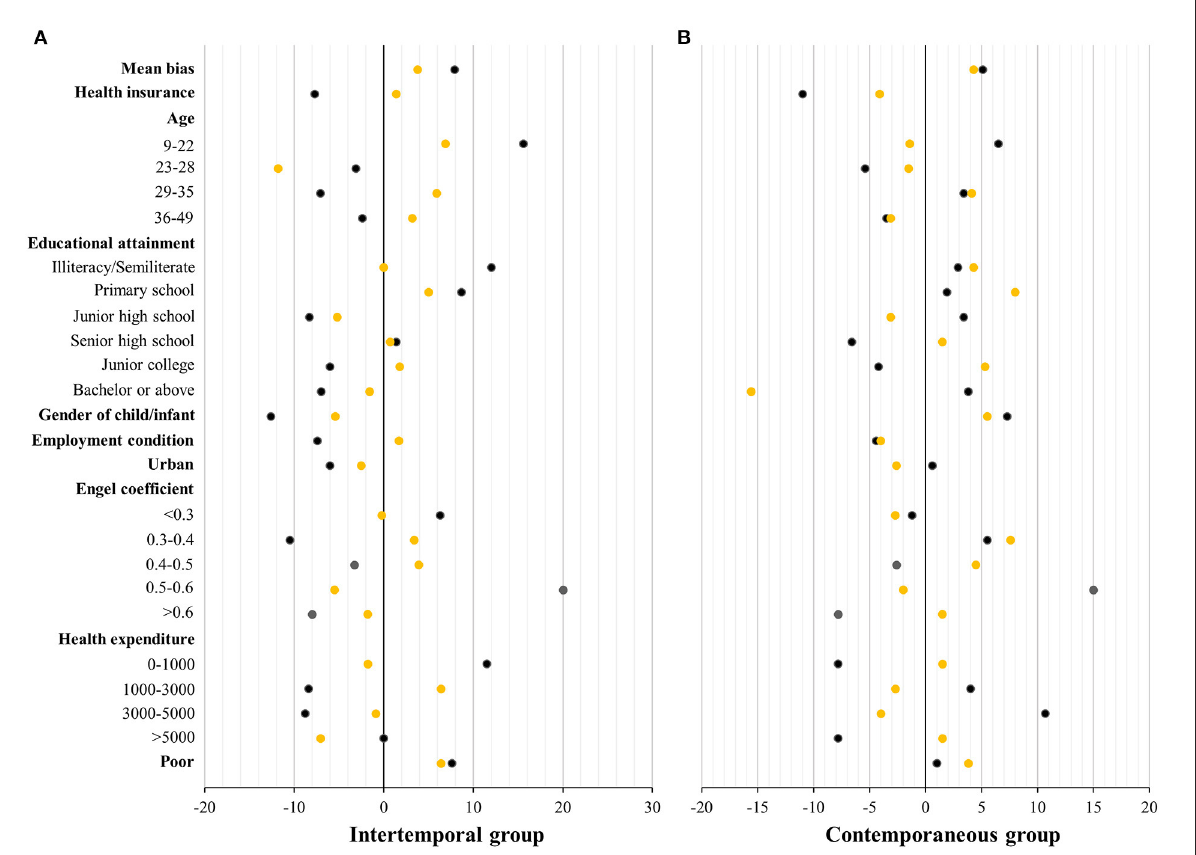
FIGURE3 Standardized differences between the treated and control groups before and after propensity score matching. The results of intertemporal group (A) and contemporaneous group (B) are displayed. The black dots represent standardized differences before matching, and the yellow dots represent standardized differences after matching. The 1:2 nearest-neighbor matching with replacement was used. Details are provided in Supplementary Tables 3, 4.